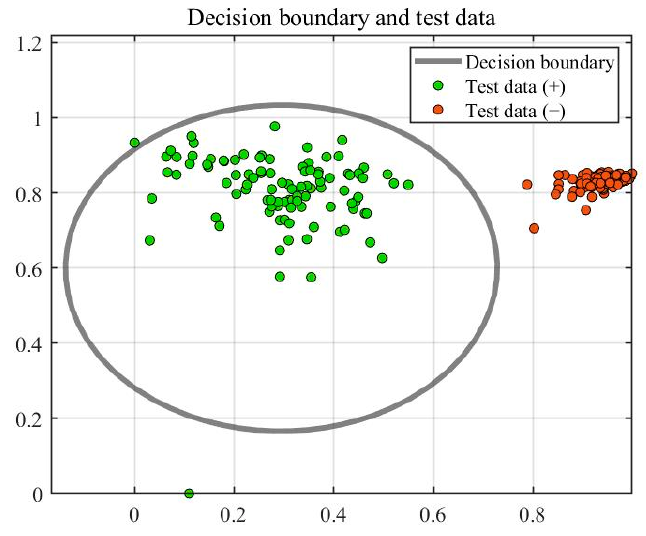
Figure 12. Training of BO − SVDD.